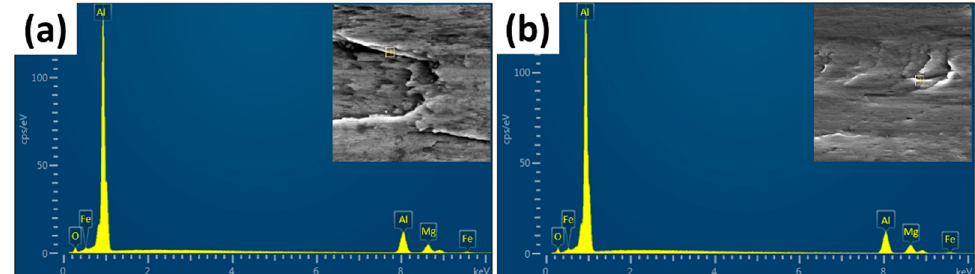
Figure 8. EDS analysis of the worn surface of the AA5052 tested under the applied normal load of 2 N: ( a ) initial annealed state and ( b ) after four passes with the CEC process.